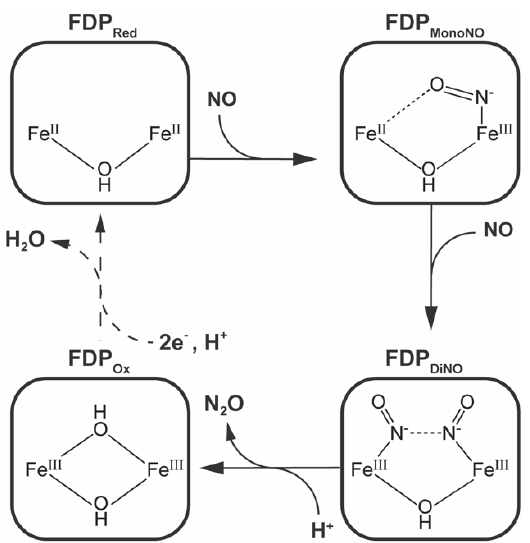
Figure 9. Proposed mechanism for NO reduction by FDPs showing the proposed diiron center structures during the FDP catalytic cycle and based on the results presented by Kurtz and co-workers [38,39]. The catalytic cycle initiates with the diiron core in the diferrous reduced state (FDP Red ), which is converted into the diiron-mononitrosyl species (FDP MonoNO ) upon reaction with the first NO molecule. The reaction with the second NO molecule gives rise to the diiron-dinitrosyl species (FDP DiNO ). Product formation is concomitant with the entrance of a proton leading to the formation a second hydroxo bridge between the two iron atoms, forming the oxidized diferric final species (FDP Ox ). The FDP Red species is restored through a two-electron reduction and the uptake of a second proton, with the release of a water molecule.